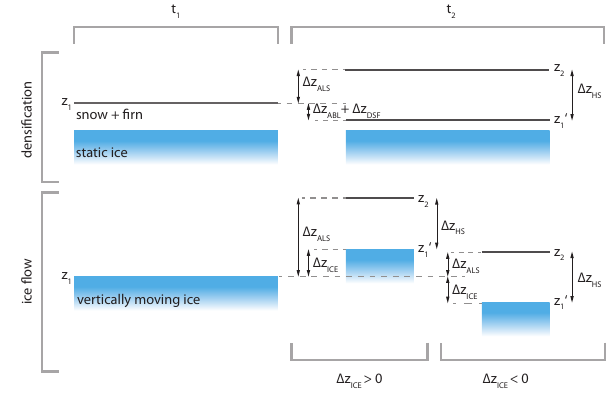
Fig. 1. Changes in surface elevation due to snow depth ( 1z HS ), ab- lation ( 1z ABL ) and densification of snow and LSC ( 1z DSF ) result- ing in ALS surface elevation changes 1z ALS between the two ALS flights ( t 1 ) and ( t 2 ). Upper part: firn and snow on top of static ice. Lower part: firn and snow on top of a vertically moving ice surface ( 1z ICE